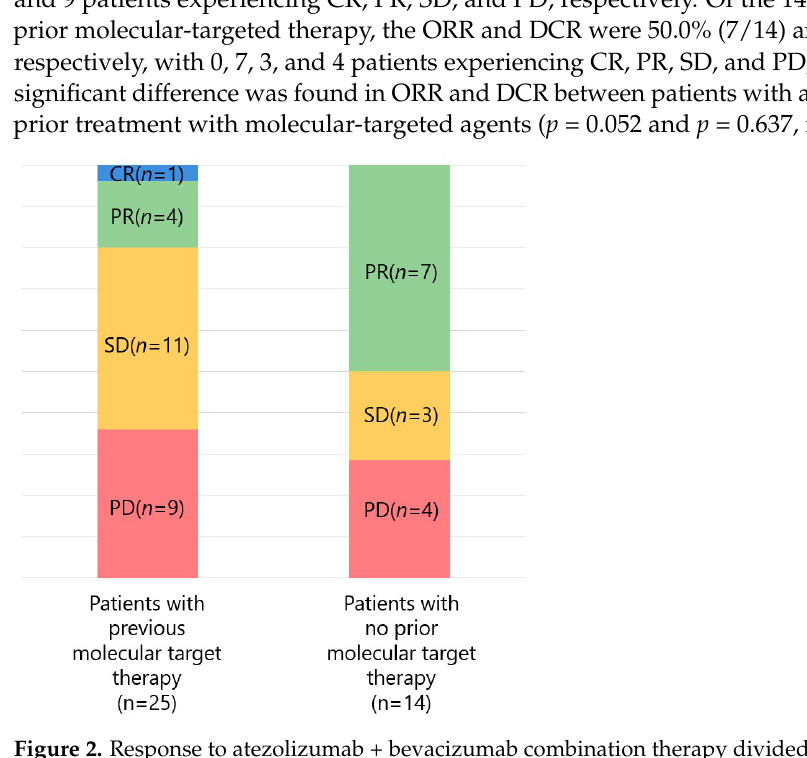
Figure 2. Response to atezolizumab + bevacizumab combination therapy divided by prior treat- ment with molecular-targeted agents (CR, complete response; PR, partial response; SD, stable disease; PD, progressive disease).